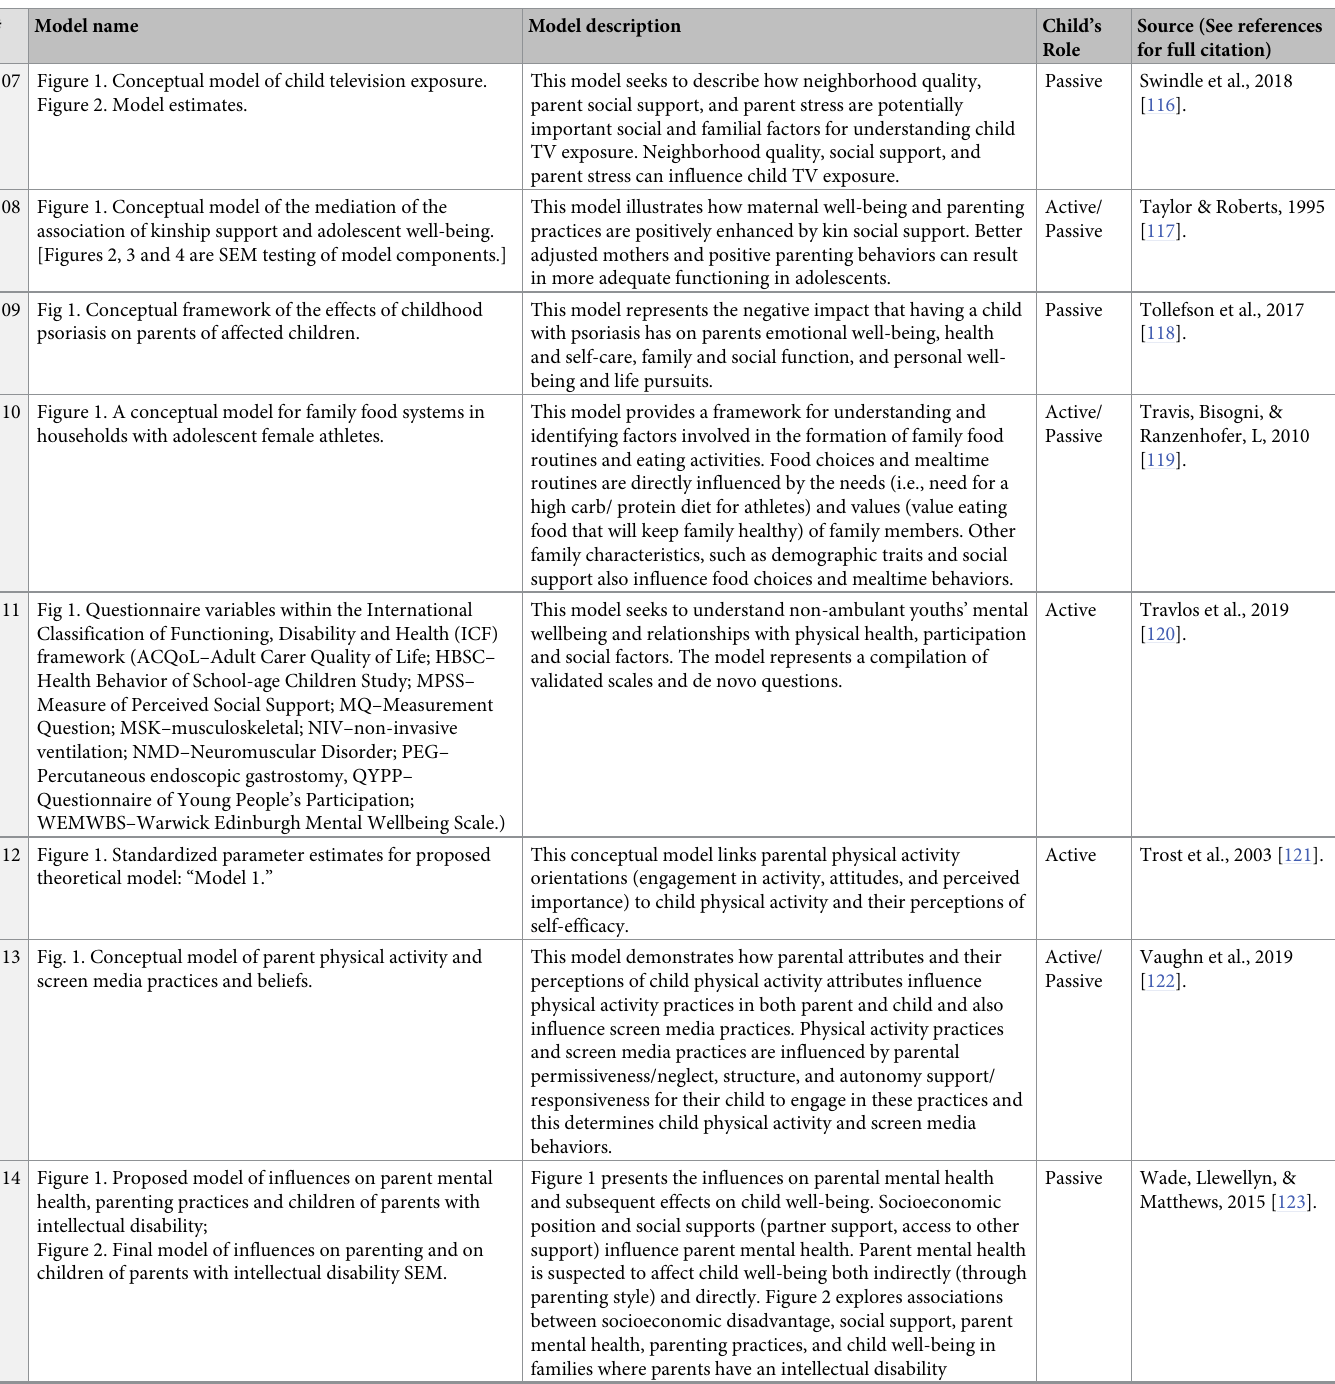
107 Figure 1. Conceptual model of child television exposure. Figure 2. Model estimates.